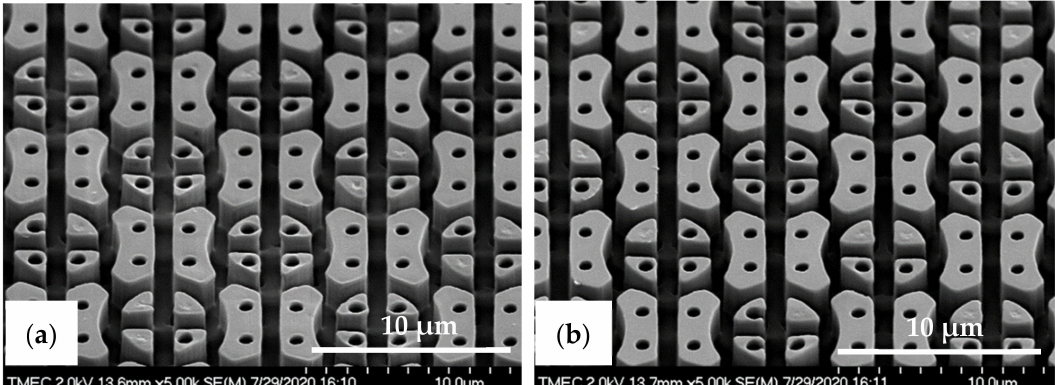
Figure 21. Tilted-view SEM images of the R2P NIL replicated C-RESS micro-structure (pattern design: size: 1.5 µ m, space: 0.5 µ m, height: 2.5 µ m) after scratch test ( a ) imprint on PC foil with resin A (C-RESS-A) and ( b ) imprint on PC foil with resin B (C-RESS-B).